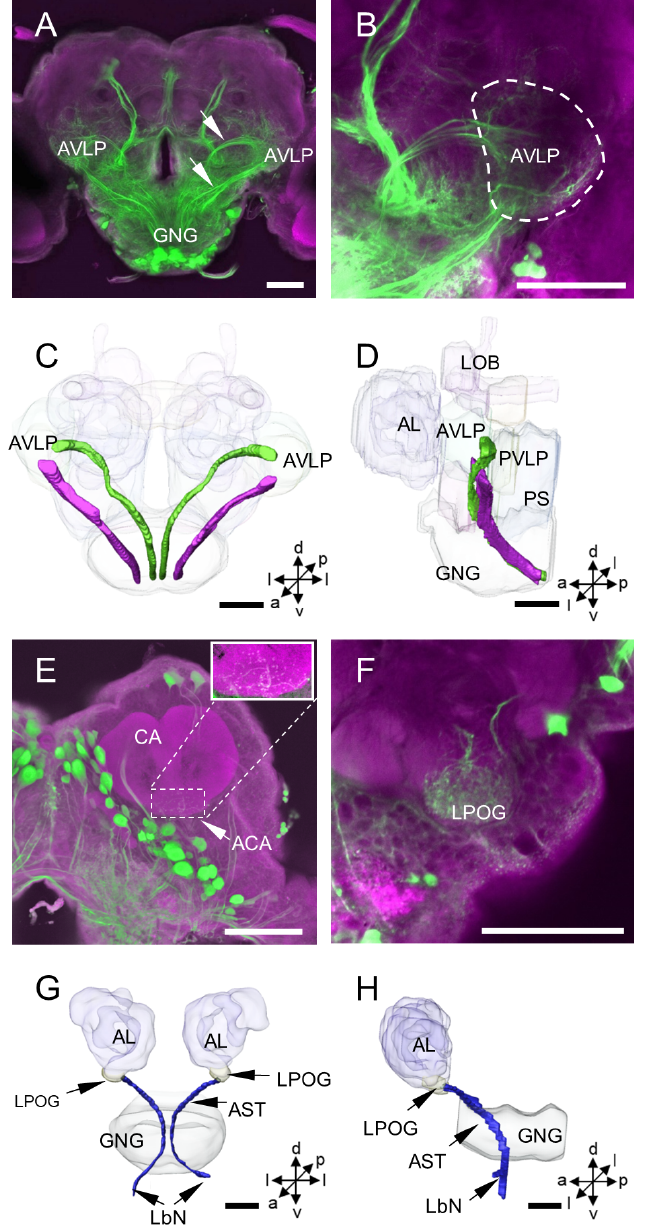
Figure 9. Neurite innervation by DNs and ascending neurons in the brain: ( A ) projection views of confocal stack images of neurite innervation by DNs and ascending neurons labeled in the brain by backfilling, arrows indicate two prominent ascending neuron axon bundles; ( B ) projection views of confocal stack images showing the target areas of two ascending neuron axon bundles; ( C , D ) the anterior and lateral views of the three-dimensional reconstruction of two ascending neuron axon bundles in the brain; ( E ) projection views of confocal stack images showing neurites labeled in the ACA by backfilling from the neck connective; ( F ) projection views of confocal stack images showing neurites labeled in the LPOG of the AL by backfilling from the neck connective; and ( G , H ) the anterior and lateral views of the three-dimensional reconstruction showing two fibers connecting the LPOG in the antennal lobe of the brain. AL, antennal nerve; ACA, accessory calyx; AST, antenno- subesophageal tract; AVLP, anterior ventrolateral protocerebrum; CA, calyx; GNG, gnathal ganglion; LbN, labial nerve; LOB, mushroom body lobes; LPOG, labial-pit organ glomerulus; PS, posterior slope; PVLP, posterior ventrolateral protocerebrum. a, anterior; d, dorsal; l, lateral; p, posterior; v, ventral. Scale bars: 100 µ